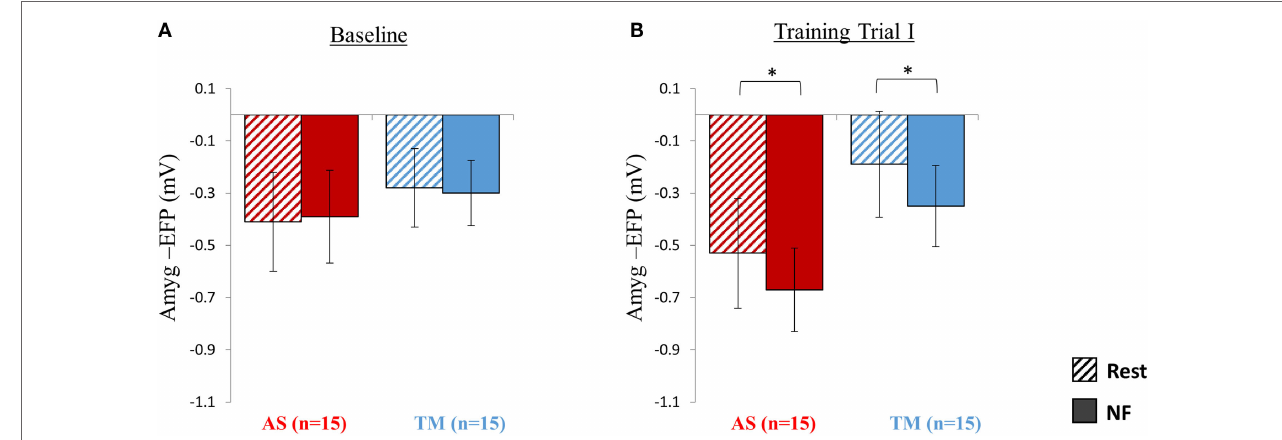
FigUre 2 | session 1 nF Training results . (a) As expected at the first baseline trial (5 min) participants were yet unable to down regulate the amyg-EFP ( Y -axis) during NF (solid bars) relative to rest (dashed bars), and no differences were observed between the groups (red bars for AS; blue for TM) (All p > 0.8). (B) By the end of the first session, during the first training trial (15 min), both groups decreased the amyg-EFP signal amplitude during NF relative to rest with no group differences. * p <